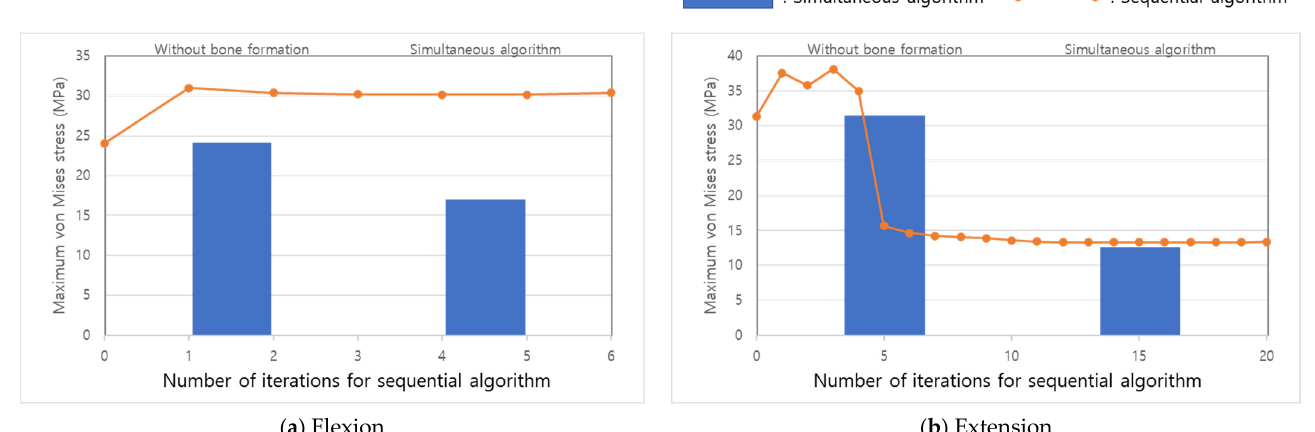
Figure 8. Changes in the maximum von Mises stress on the interbody cage when simulating bone formation using two algorithms during ( a ) flexion and ( b ) extension.